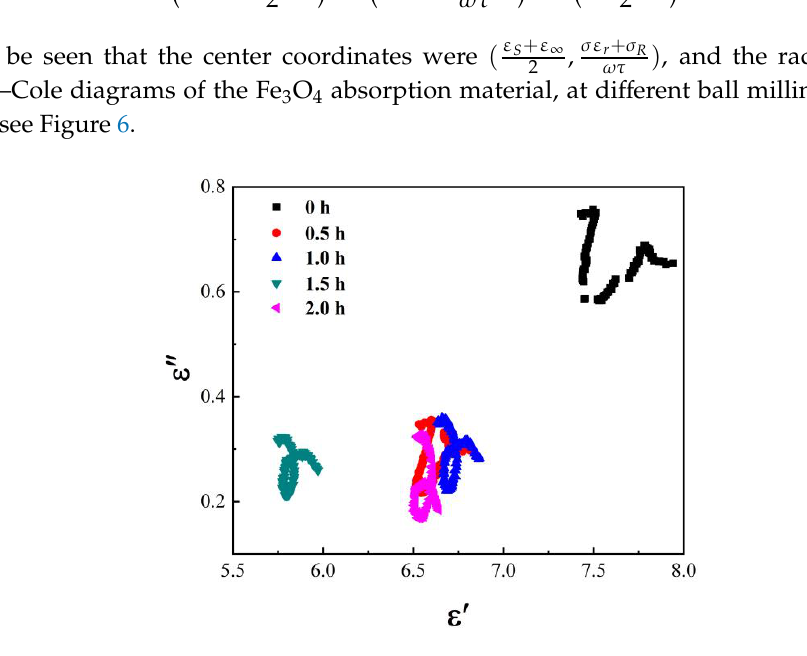
Figure 6. Cole–Cole diagram of the Fe 3 O 4 absorption material at different ball-milling times.